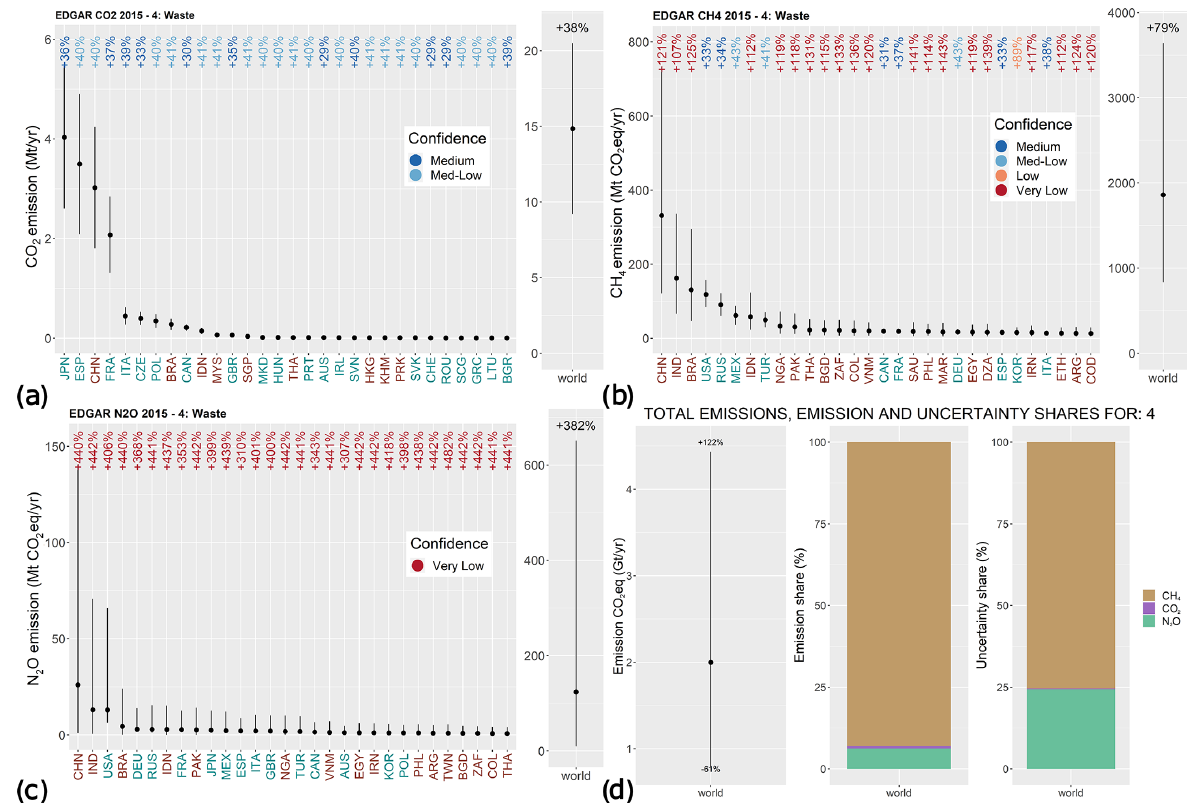
Figure 9. GHG emissions from the top emitters and the world for sector 4 (waste): (a) CO 2 ; (b) CH 4 ; (c) N 2 O; (d) the world total emission uncertainty and the emission and uncertainty shares. The country names are colour-coded according to their classification (cyan denotes industrialized, and red denotes developing). Confidence levels are given in the following ranges: high (0,10%]; medium-high (10%, 20%];